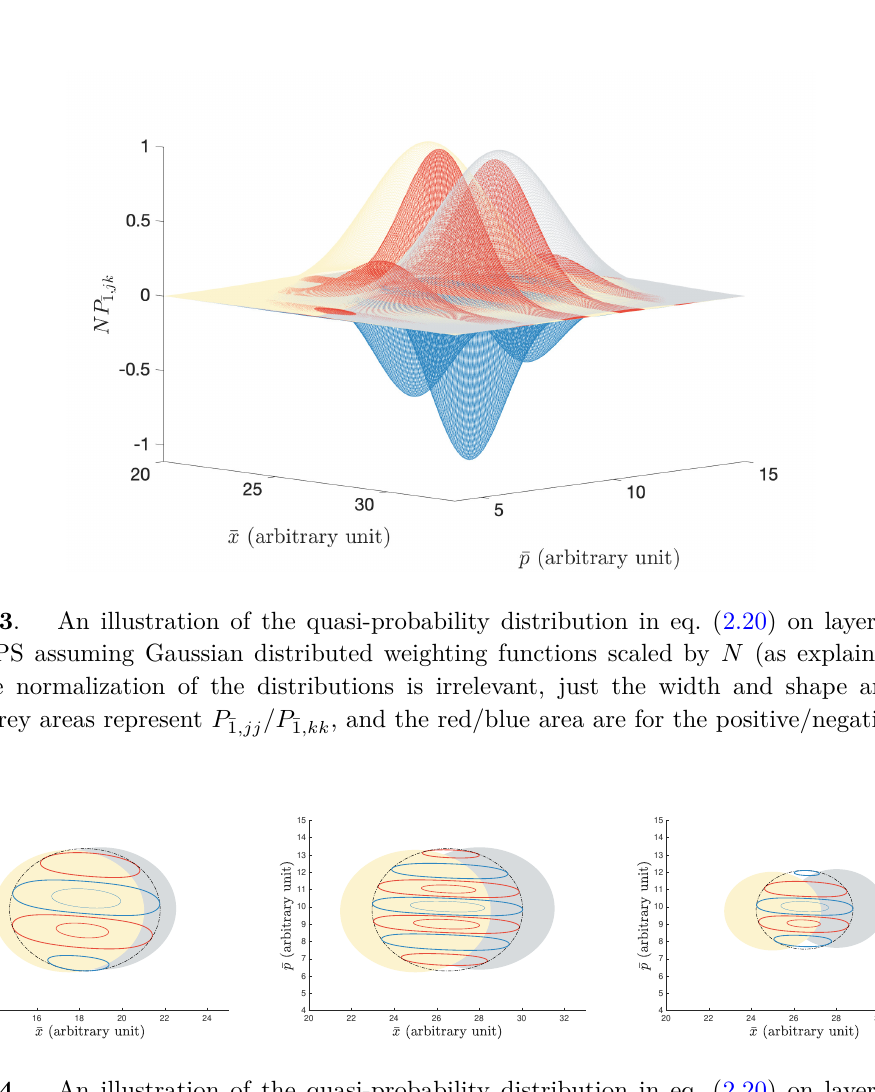
Figure 4 . An illustration of the quasi-probability distribution in eq. (2.20) on layer 1 in the Wigner-PS assuming Gaussian distributed weighting functions. These plots show the projection of 3D plots like figure 3 onto 2D plots. The edge of the shaded areas, the (outer) thick solid lines and the dashed lines are contour lines for the distributions within two standard deviations, while the (inner) thin lines are for one standard deviation. The shaded areas represent P and P , ¯1 ,jj ¯1 ,kk the red/blue lines are for the positive/negative values of P , and the black dashed line shows ¯1 ,jk the weighting function for P . The three plots differ by the traveling time ( T ) and width ¯1 ,jk plot ( σ = σ = σ ) as: T = T and σ = σ , also σ = 0 . 325 σ or plot p x left < T middle right left middle right left 1 . 376 σ left